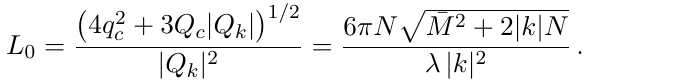
Figure 8 . (Left) Quark-antiquark potential for several B + shown as a continuous black curve. M 0 and L 0 are given in (7.11) and (8.1), respectively. The red, dashed horizontal line at the bottom of the plot corresponds to the value of V L for the OP (cid:12)xed point. (Right) Quark-antiquark potential for several B (cid:0) as dictated by (7.4), where (cid:26) 0 is the scale of the B conf shown as a continuous black